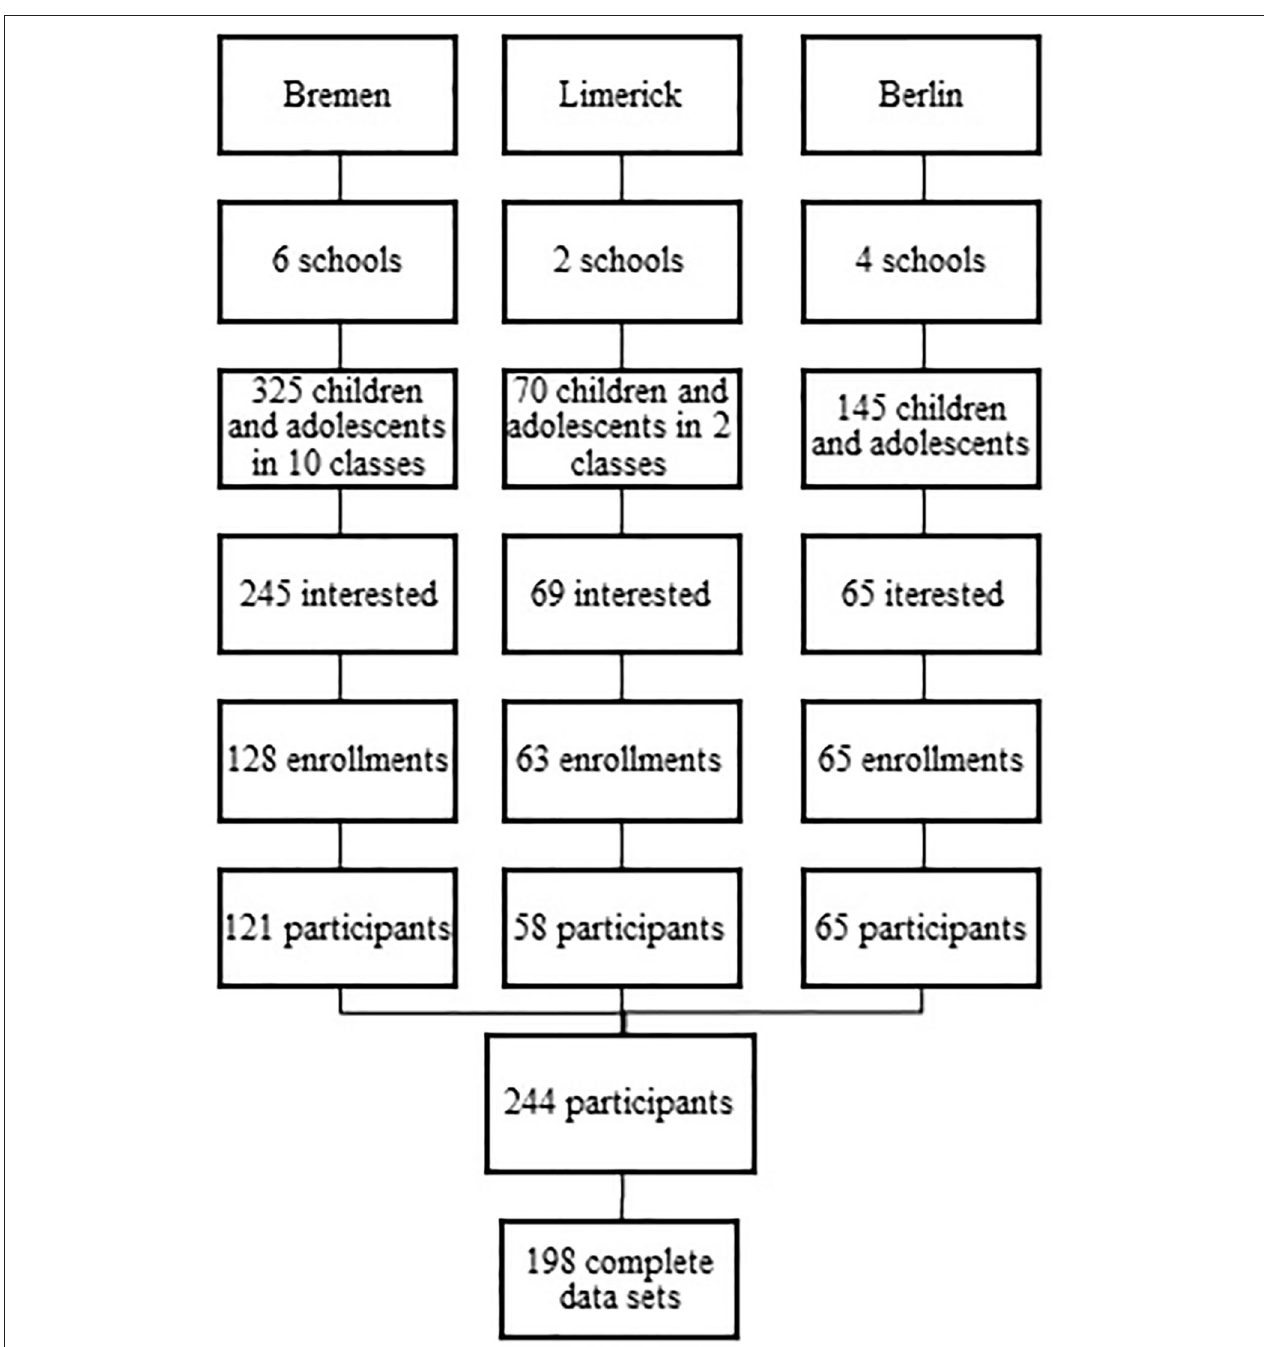
FIGURE 1 | Recruitment of the study